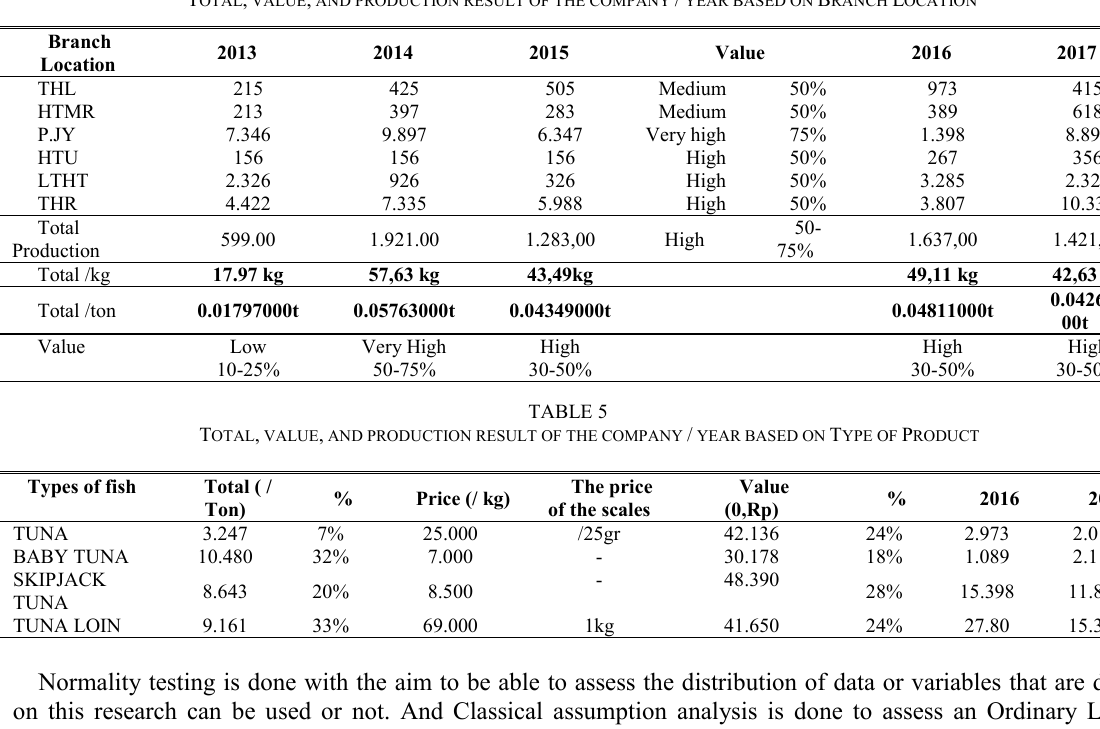
TABLE 4 T OTAL , VALUE , AND PRODUCTION RESULT OF THE COMPANY / YEAR BASED ON B RANCH L